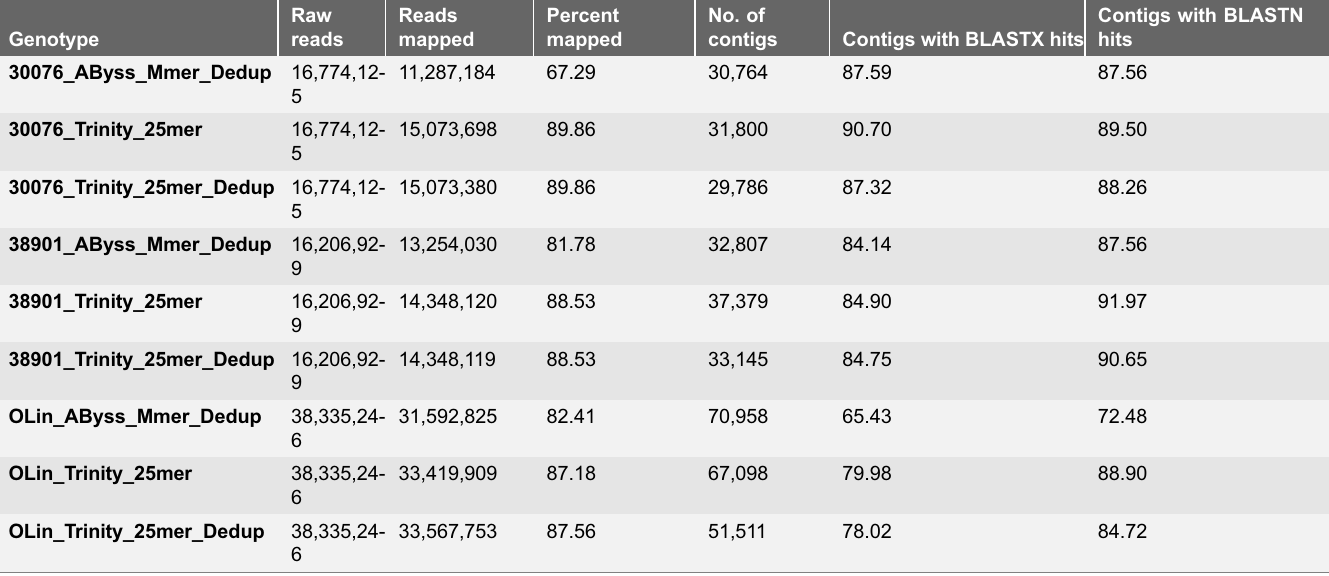
Table 5. Statistics on the BLASTX, BLASTN and re-mapping of the raw reads to assemblies respectively.